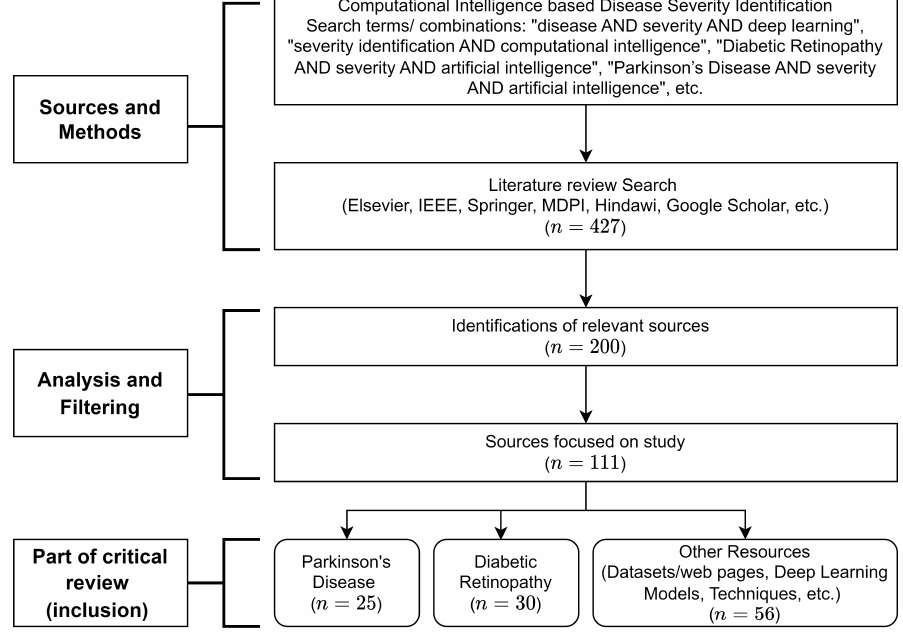
Figure 1. Strategy for inclusion of sources for this